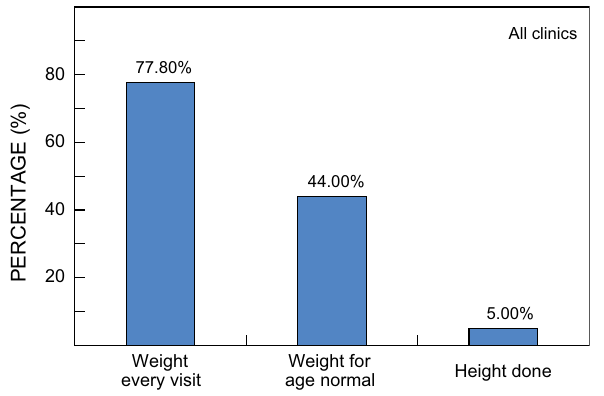
Figure 4: Nutritional measurement across the district (2014).